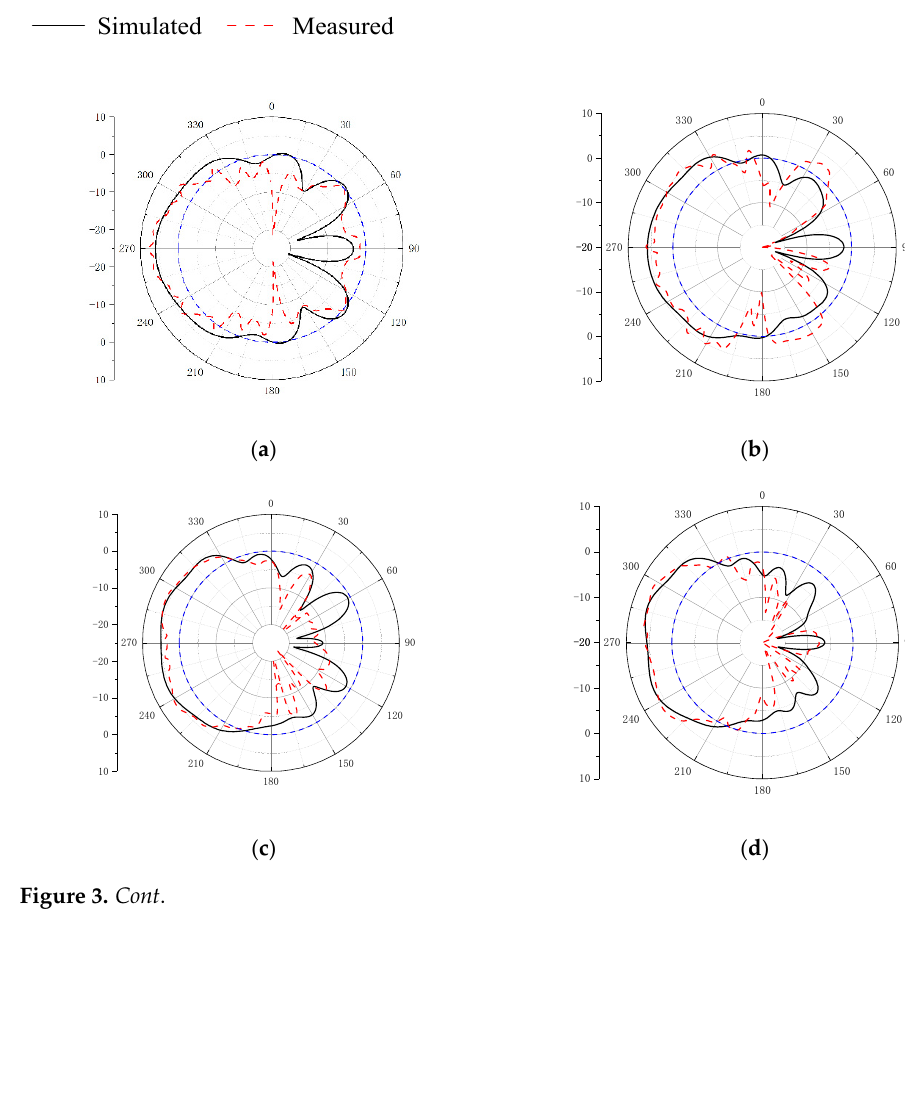
Figure 2. ( a ) Return loss of the measured and simulated transmitting antenna. ( b ) The gain of the simulated transmitting antenna.